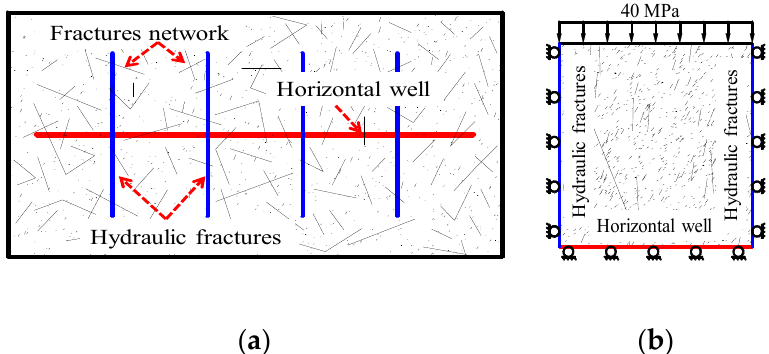
Figure 2. Schematic of ( a ) fractured shale reservoir model; ( b ) simulation fracture network model geometry.